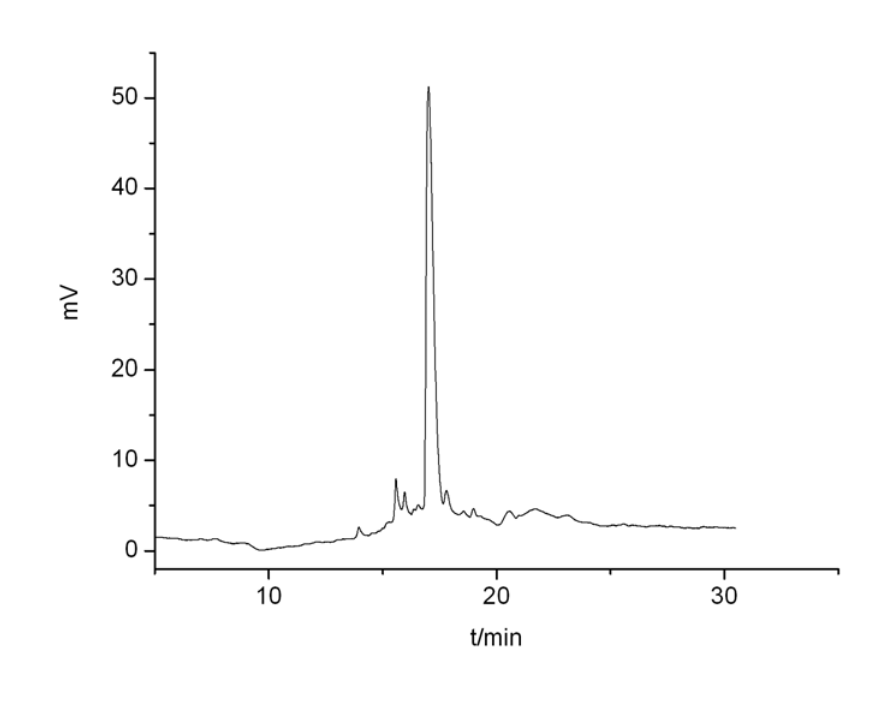
Fig. 3 RP-HPLC profile of crude heptapeptide 2 (t R 17.02